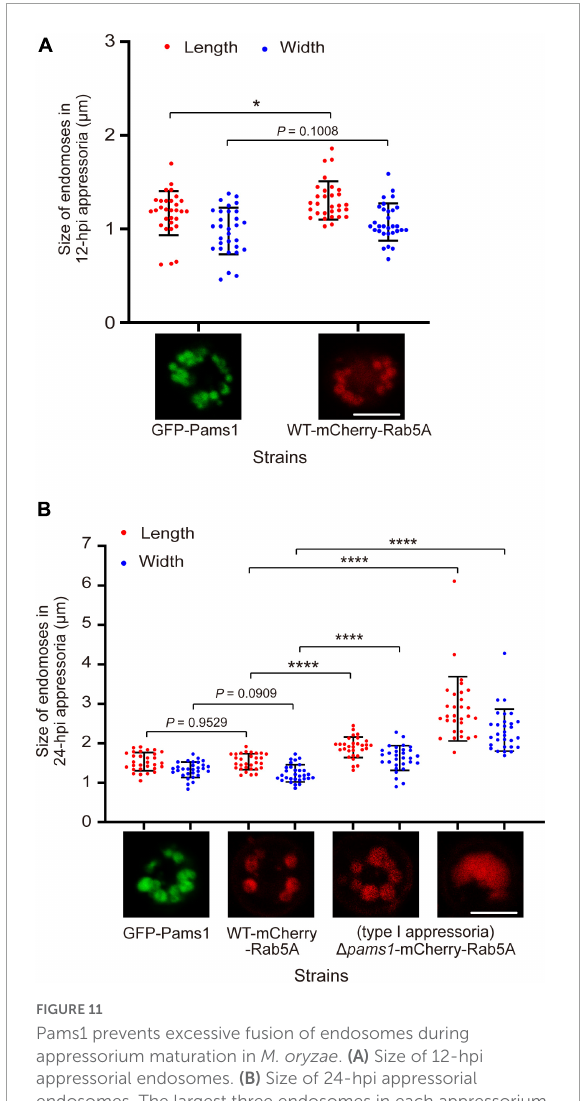
FIGURE11 Pams1 prevents excessive fusion of endosomes during appressorium maturation in M. oryzae . (A) Size of 12-hpi appressorial endosomes. (B) Size of 24-hpi appressorial endosomes. The largest three endosomes in each appressorium were selected to measure their size, and a total of 10 appressoria were measured. The strains used here are as follows: GFP-Pams1 (the complementation strain of (cid:49) pams1 expressing GFP-PAMS1 ), WT-mCherry-Rab5A (the wild type strain expressing mCherry-RAB5A ), and (cid:49) pams1 -mCherry-Rab5A ( (cid:49) pams1 expressing mCherry-RAB5A ). Spore suspensions were inoculated on hydrophobic borosilicate glass coverslips and incubated for 12 or 24 hpi. The GFP-Pams1 and WT-mCherry-Rab5A strains formed normal appressoria, and the (cid:49) pams1 -mCherry-Rab5A strain formed two types of abnormal appressoria, in which only endosomes or endolysosomes in type I appressoria were measured. * p < 0.05, **** p < 0.0001. Scale bars, 5 µ